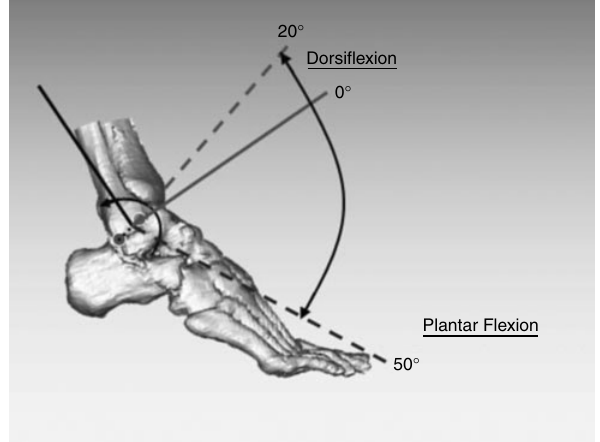
Figure 2 The ankle rotating in one degree of freedom, that of dorsiflexion/plantar